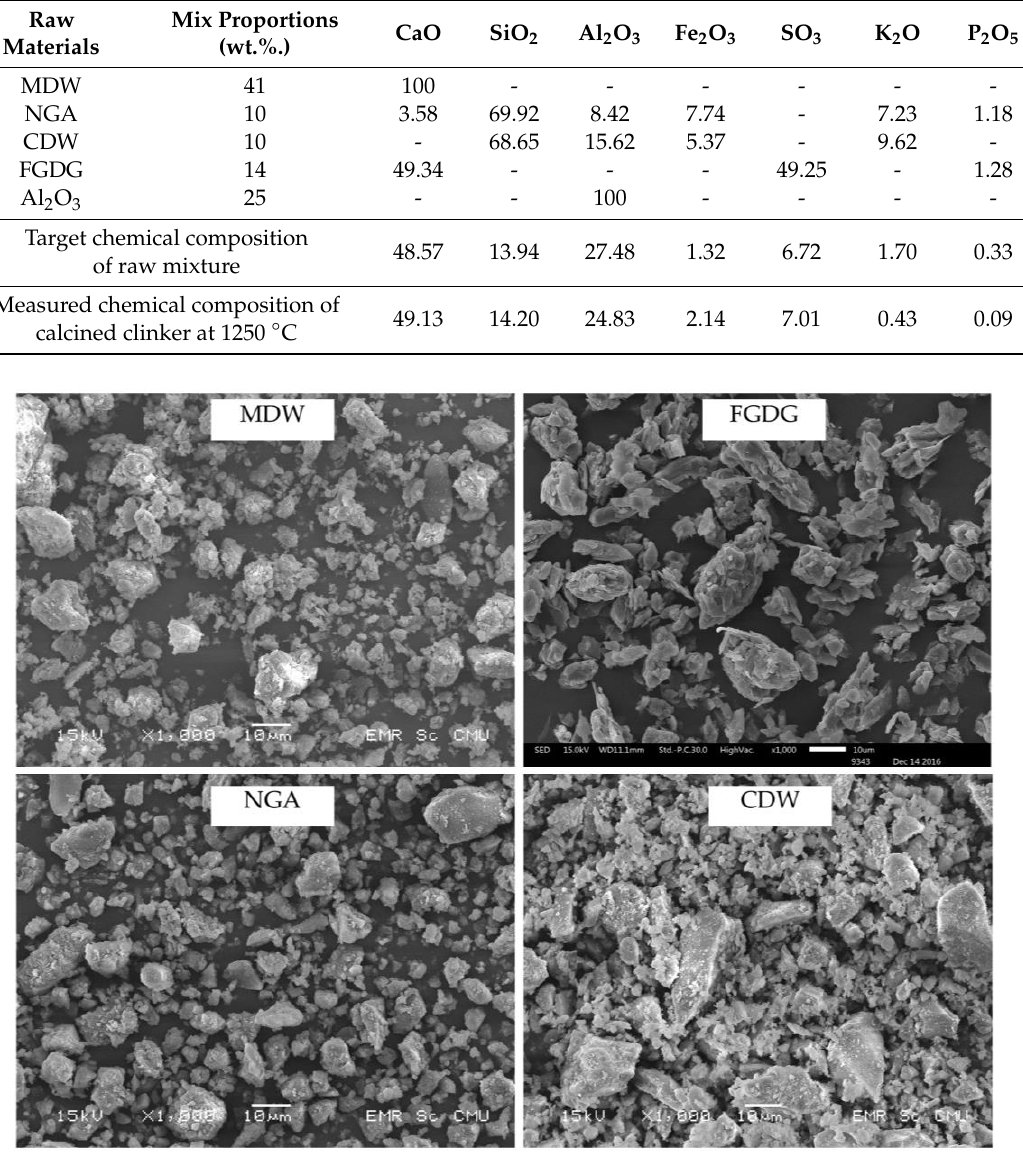
Table 2. Chemical composition of the four industrial waste materials used, laboratory reagent grade Al 2 O 3 powder, target chemical composition of the raw mixture, and measured chemical composition of the clinker fired at 1250 ◦ C.